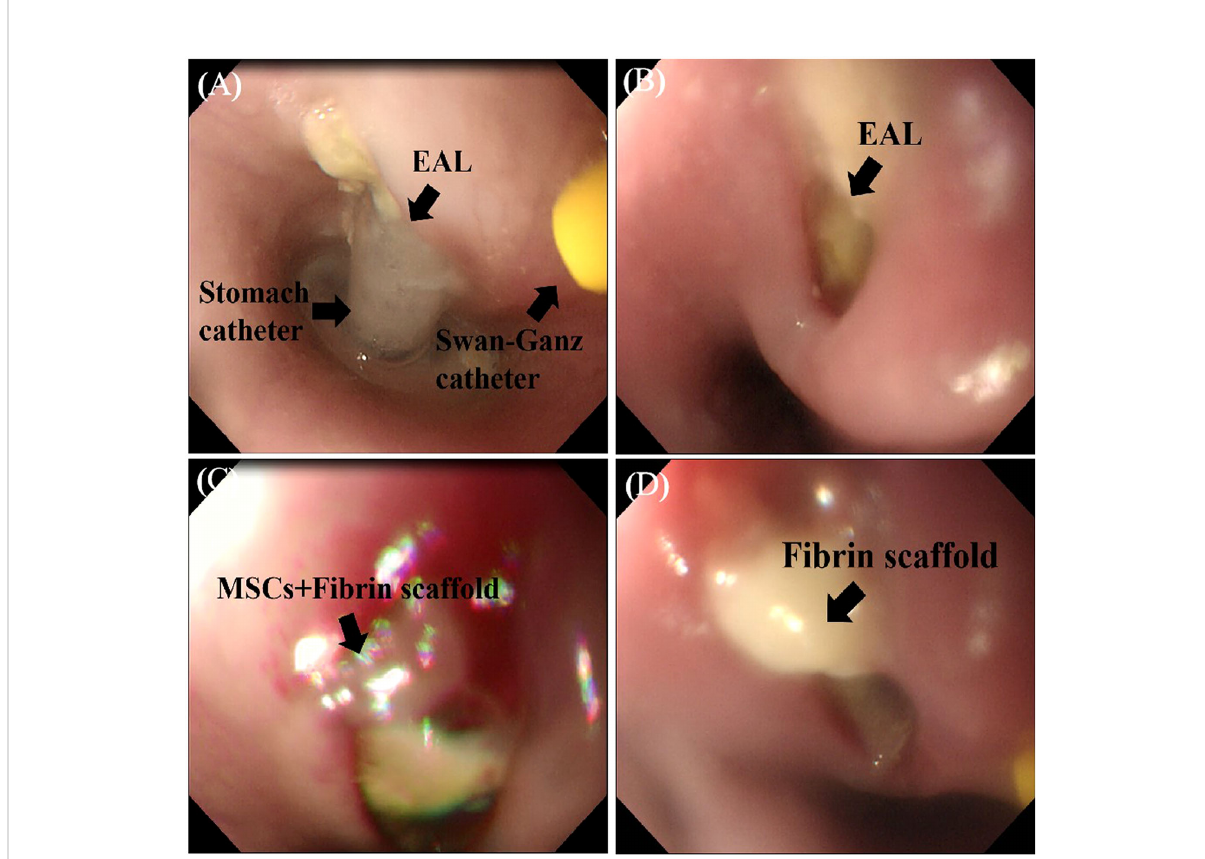
FIGURE 3 MSCs engrafted in a FS and delivered to the EAL site. (A) , The observation of EAL conditions via gastroscope after one week. (B) , Gastroscope showing EAL after removal of stomach catheter. (C) , Injection of 2 mL FS containing 2×10 7 MSCs (treatment group) around the leakage. (D) , Injection of 2 mL FS (control group) around the leakage. EAL, esophageal anastomotic leakage; MSCs, mesenchymal stromal cells; FS, fi brin